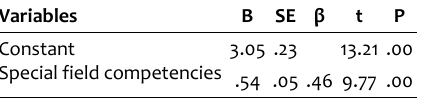
Table 4. Regression analysis on predicting expected teacher possible selves Variables Constant Special field competencies